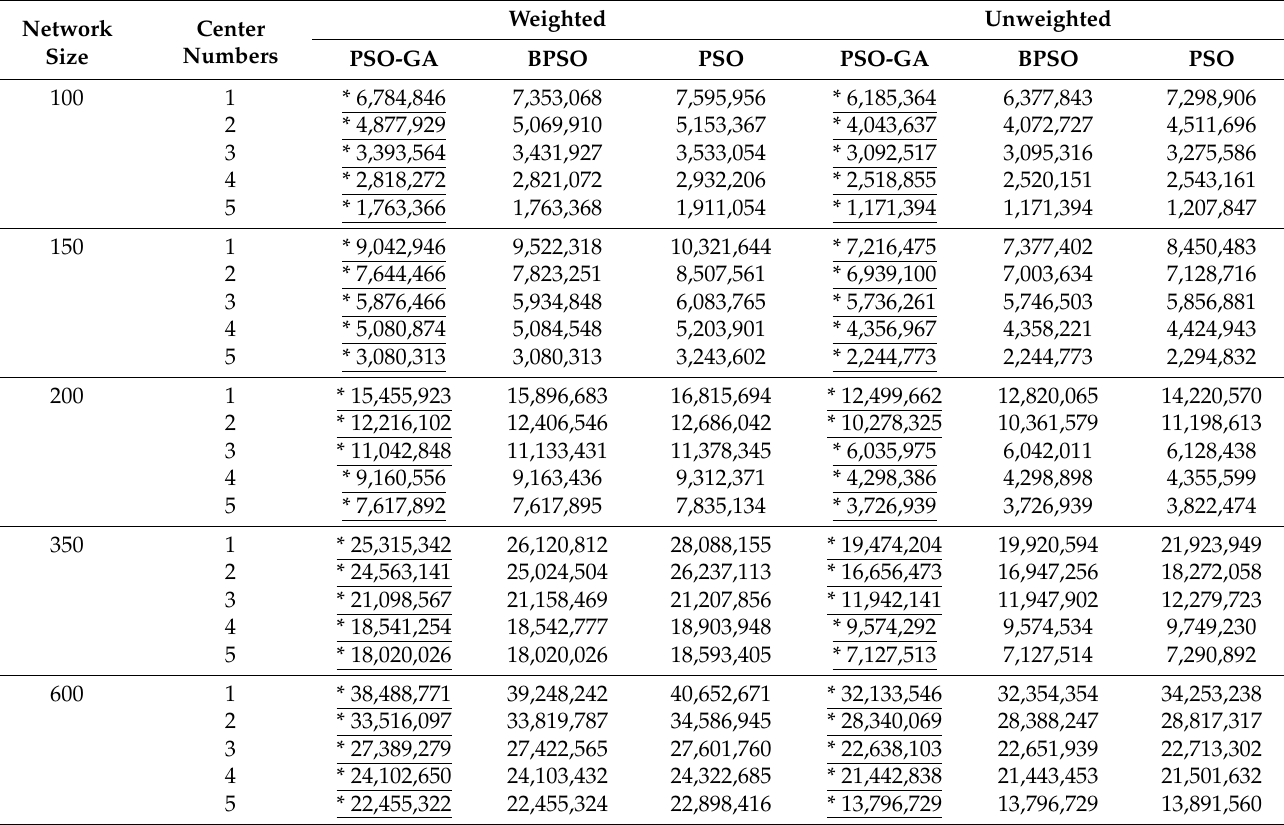
Table 8. Total cost for weighted and unweighted logistics